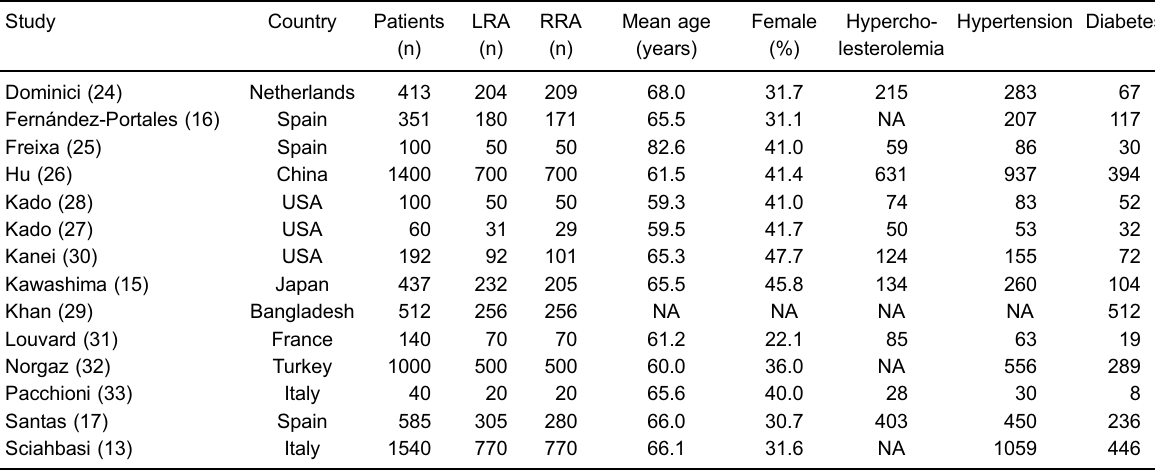
LRA: left radial approach; RRA: right radial approach; NA: not